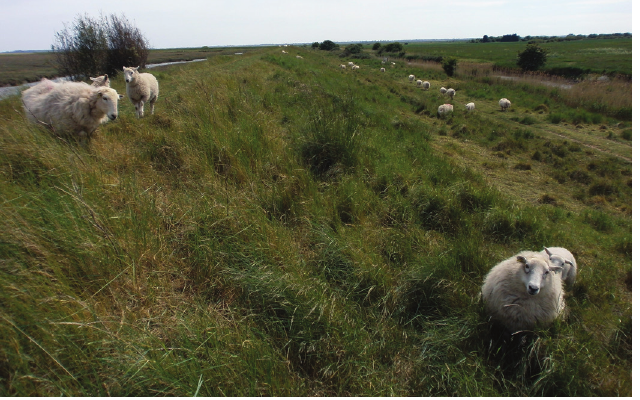
Fig. 3. Light sheep grazing on a sea wall creating a heterogeneous, patchy sward favorable for Orthoptera (Little Oakley, Essex, UK); credit T. Gardiner.